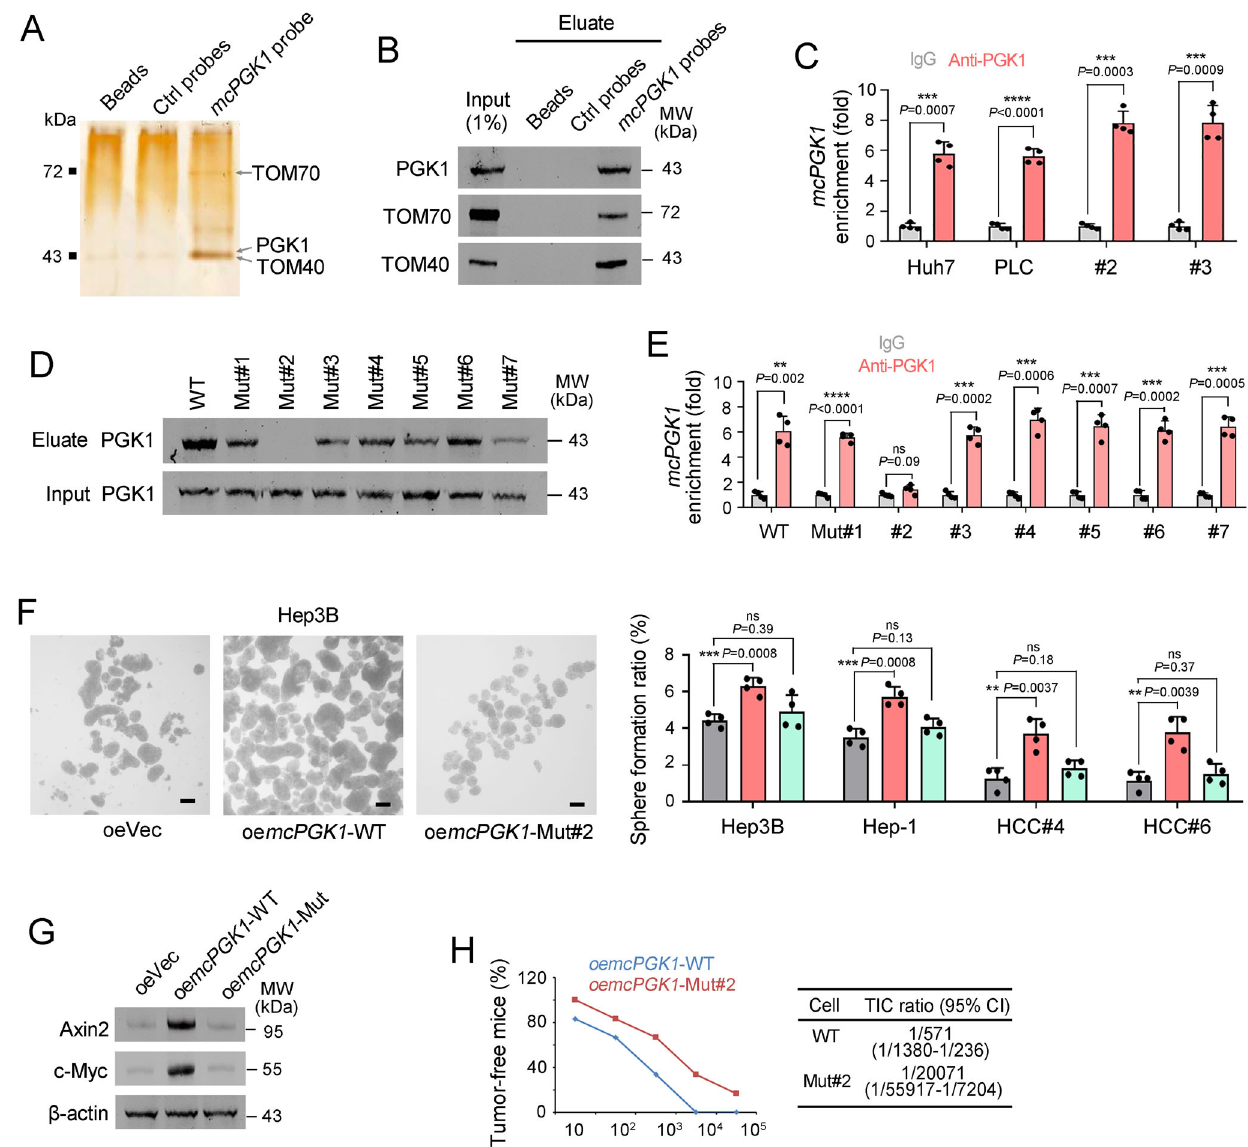
Fig. 6 | McPGK1 functions as PGK1 partner. A Silver staining of RNA pulldown eluate, for which mcPGK1 probes, control probes, and Huh7 sphere lysate were used.Thespeci fi cbandsindicatedbyblackarrowswereidenti fi edasPGK1,TOM70 and TOM40 via mass spectrum. B Immunoblot of RNApulldown eluate to con fi rm theinteractionof mcPGK1 withPGK1,TOM70andTOM40.Huh7sphereswereused for RNA pulldown. C Quantitative real-time PCR for mcPGK1 enrichment in eluate sample from RNA immunoprecipitation, in which IgG and PGK1 antibodies were used. mcPGK1 enrichmentlevelswerenormalizedtoIgGgroup. D WTandindicated mutant mcPGK1 were used for TRAP assay, and the enrichment of PGK1 in TRAP eluate was evaluated through immunoblot. E Quantitative real-time PCR for the enrichment of mcPGK1 in PGK1 RIP eluate. For RIP, mcPGK1 lowly expressed cells